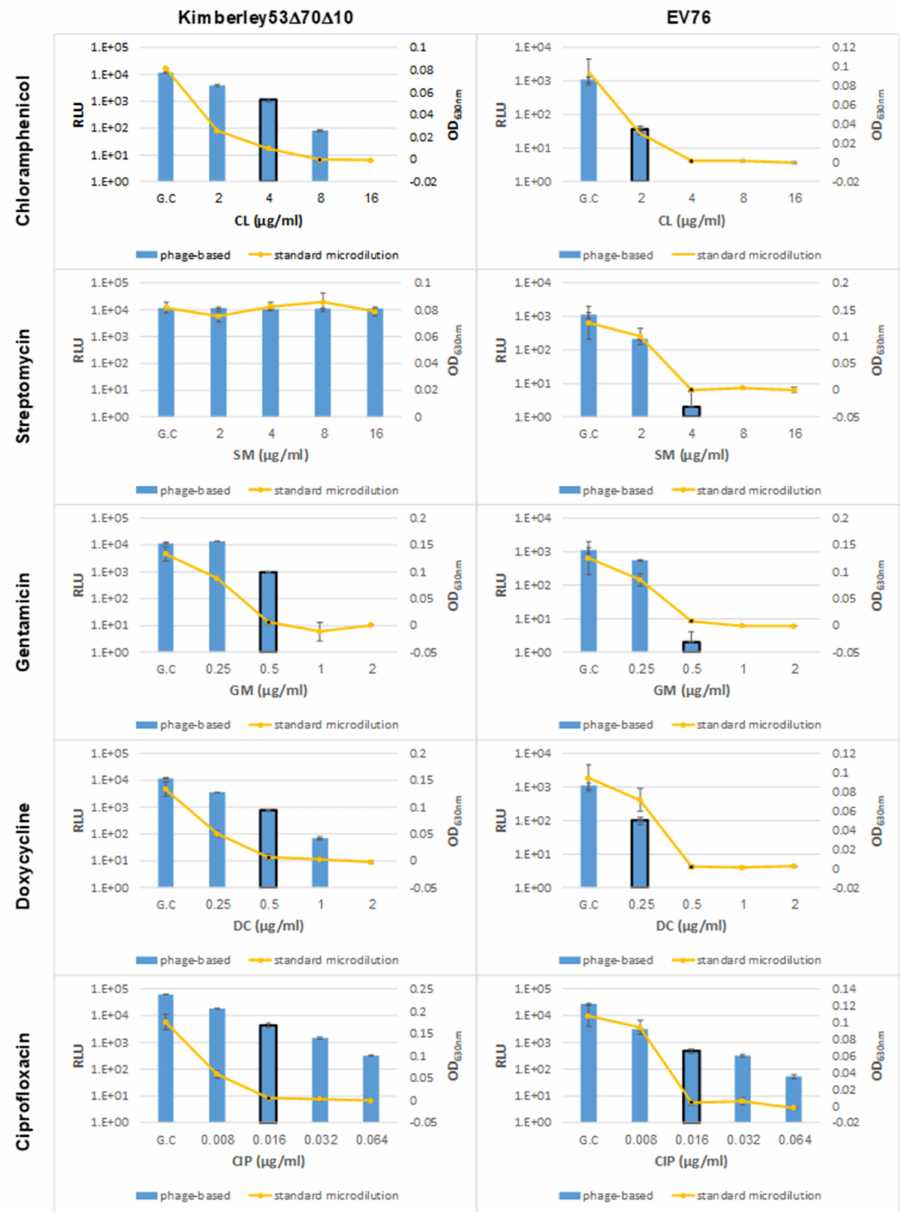
Figure 5. Direct phage-based AST of human blood cultures. Y. pestis strains Kimberley53 ∆ 70 ∆ 10 and EV76 were inoculated into human blood cultures in a Bactec aerobic plus/F bottle and incubated in a BACTEC FX40 instrument until a positive signal was obtained. Bacteria were separated from blood components by centrifugation of 8 mL of positive blood culture in an SST, resuspended in 8 mL of MHB and diluted 1:100 with MHB. The diluted culture was used for phage-based AST, with an exposure time of 7 h to CL, SM, GM and DC and 14 h to CIP. Bioluminescent values (RLU, blue bars) are displayed in comparison to OD 630 values obtained by the standard microdilution test performed with antibiotic exposure of 5 × 10 5 CFU/mL of MHB-suspended bacteria (yellow curves). The MIC values obtained by the phage-based AST are marked by a black frame around the relevant bar, and the MIC values obtained by the microdilution test are marked by a black dot. Values are the mean of three triplicate wells in the same experiment (error bars represent the standard deviation). GC = Growth